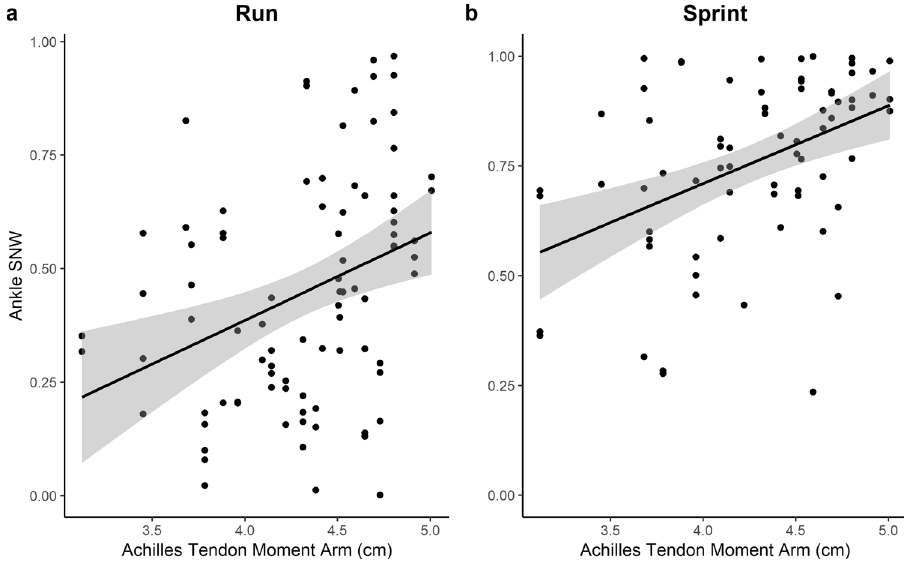
Figure 2. Scatter plots of SNW and the Achilles tendon moment arm length at running ( A ) and sprinting speeds ( B ) against AT moment arm length. The black lines are least squares best fit lines and the gray bands represent 95% confidence intervals.